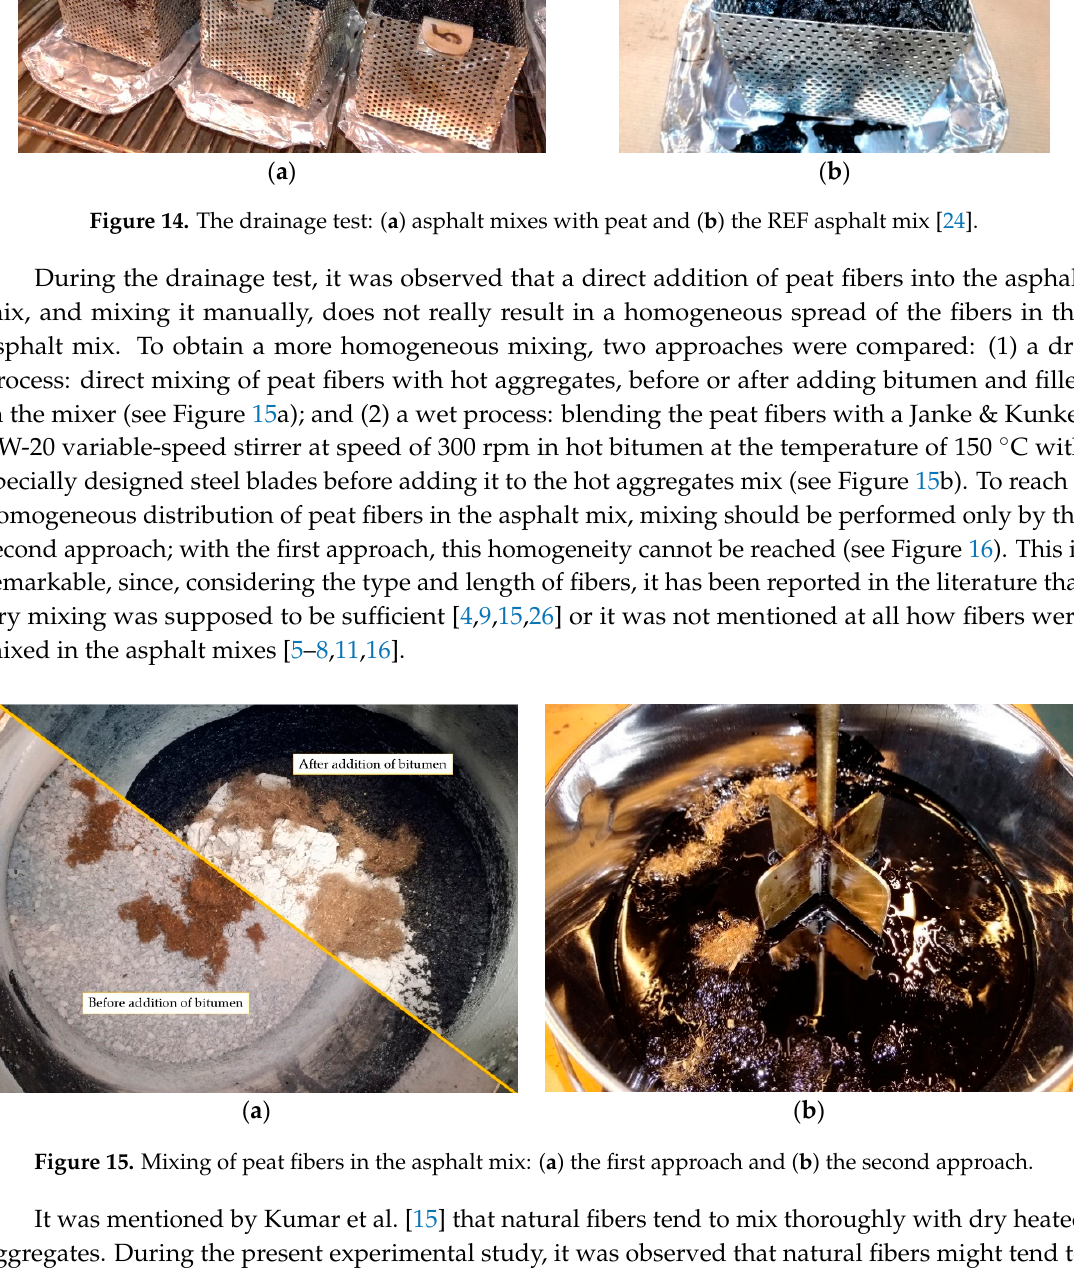
Figure 15. Mixing of peat fibers in the asphalt mix: ( a ) the first approach and ( b ) the second approach.